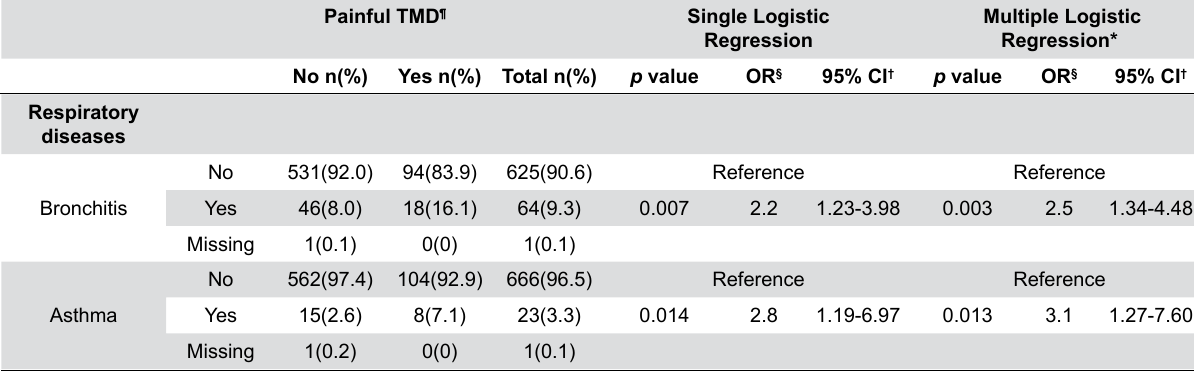
Table 2- Logistic regression model for the association between painful TMD and systemic